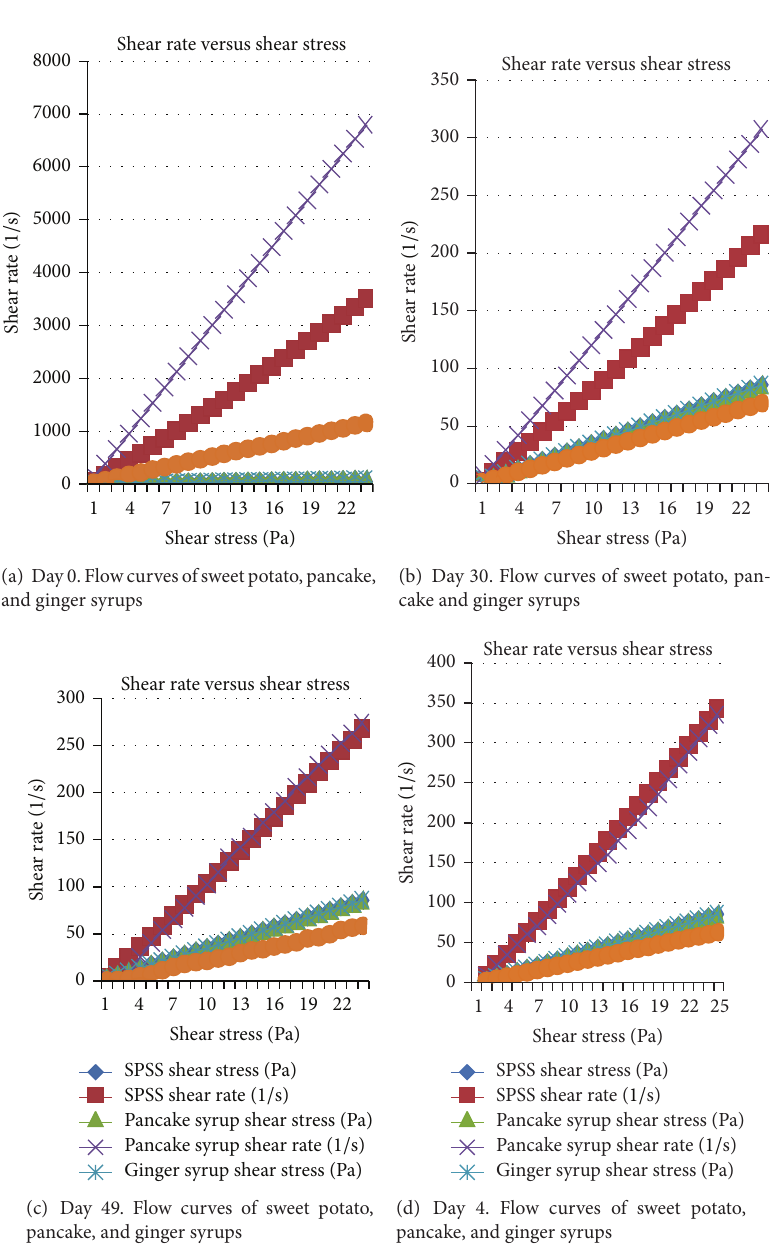
Figure 3: Flow curves for sweet potato starch, pancake, and ginger